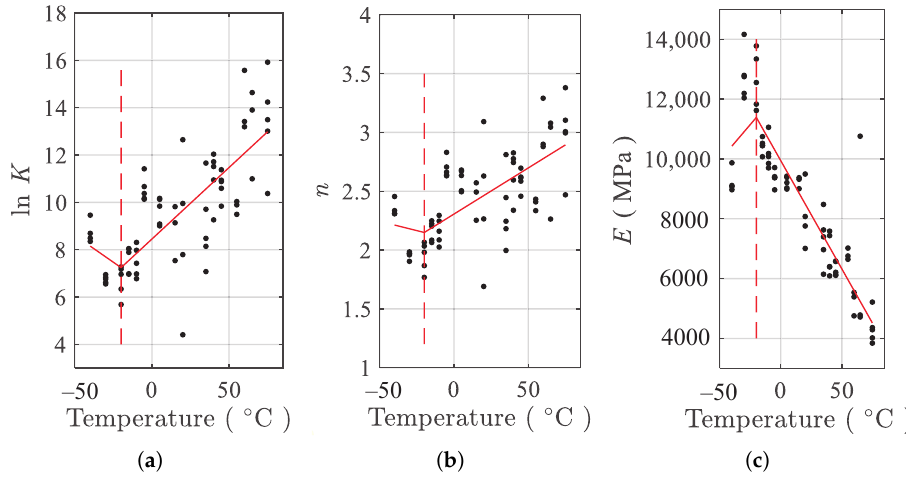
Figure 7. Temperature dependence of parameters under tension. ( a ) ln K , ( b ) n , and ( c ) E